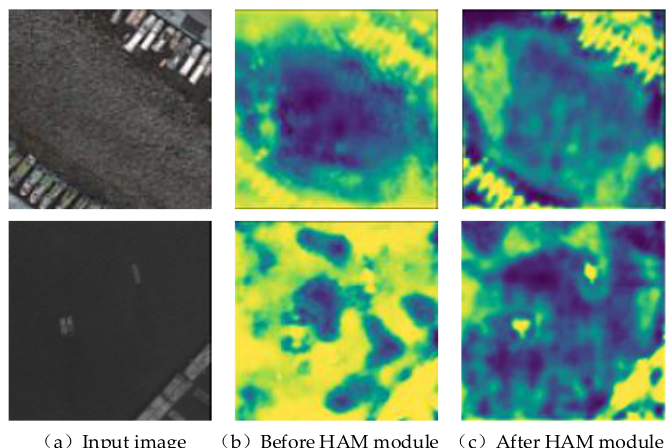
Figure 7. Visualization results comparison of different methods with or without HAM.